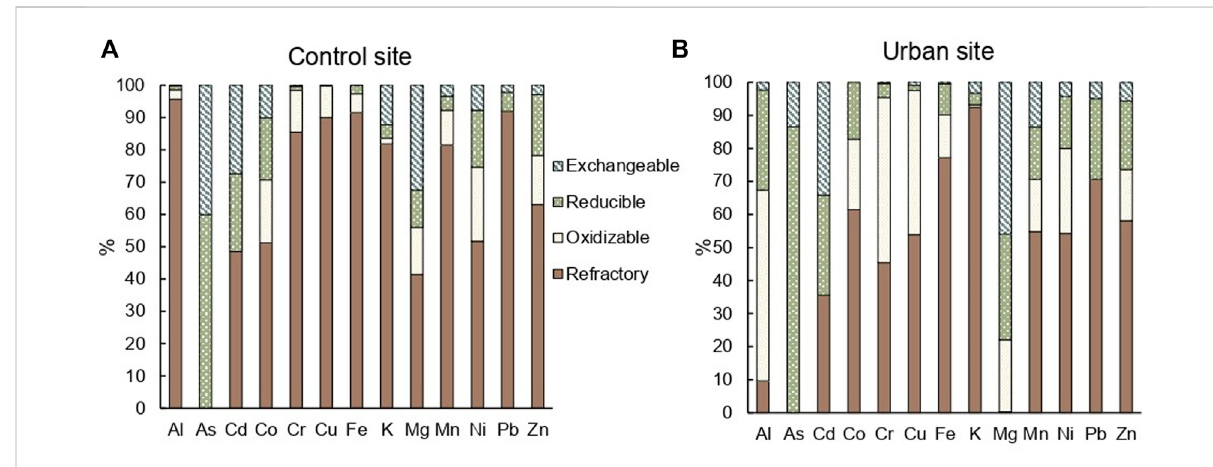
FIGURE 4 Meanpercentagecompositionofelementsineachfraction(exchangeable,reducible,oxidizable, refractory) obtainedbysequentialextractions of the entire soil cores in triplicates at the (A) control site and (B) urban